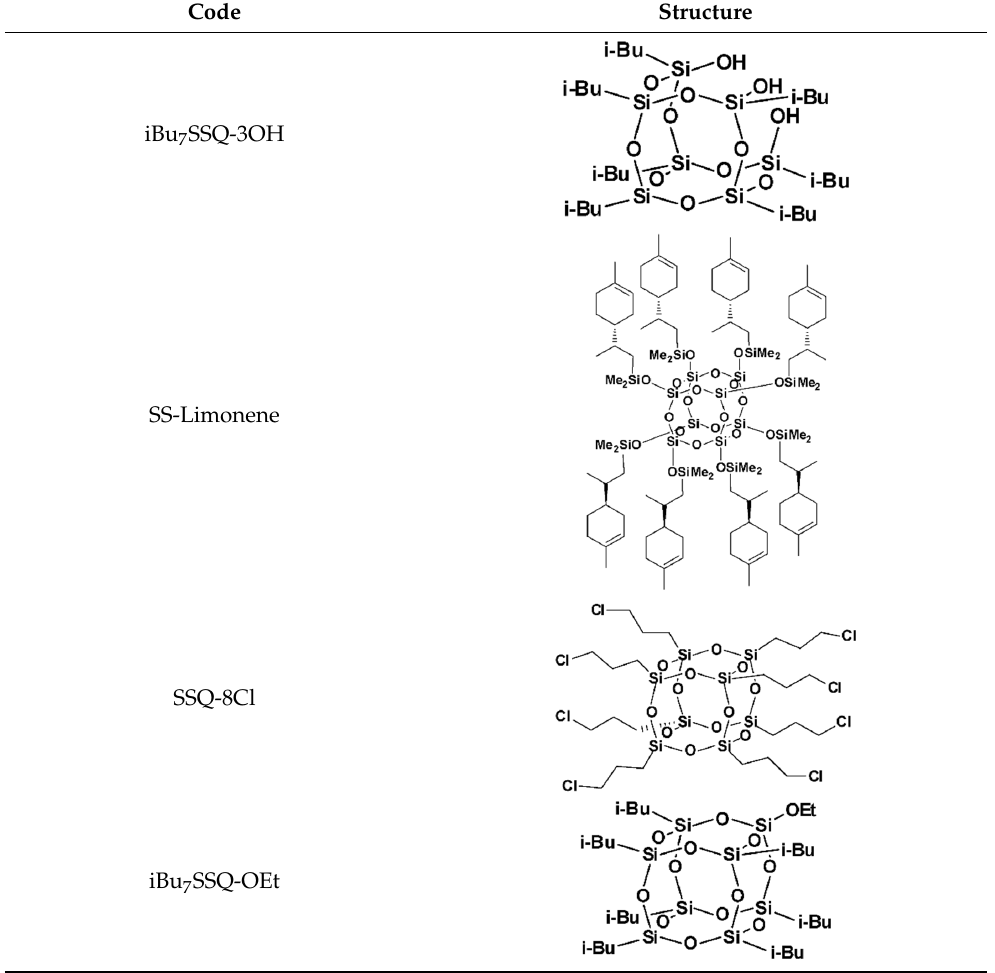
Table 1. Structure and codes of the modifiers used in this study.